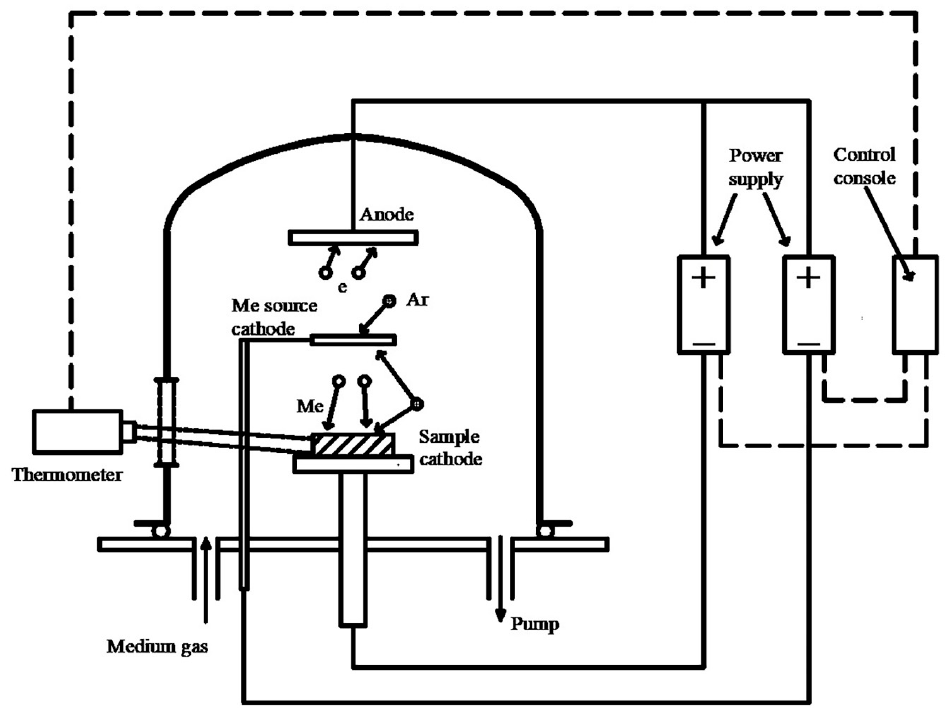
Figure 1. Schematics of the basic hardware setup for DGP surface alloying technology. Table 1. Process parameters of double glow plasma (DGP) tantalum and tungsten surface alloying treatment